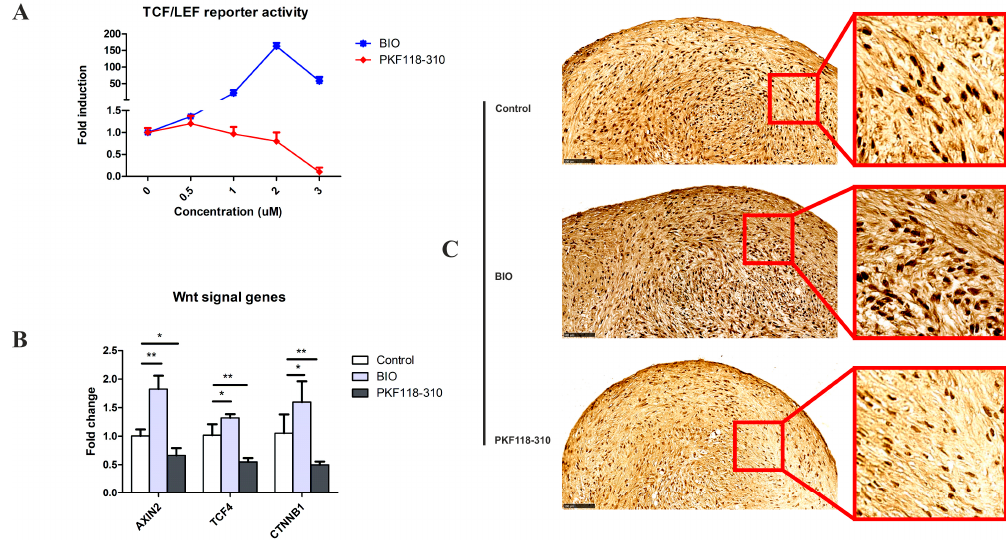
Figure 1. The efficacy and specificity of BIO and PKF on TCF/LEF reporter and hMSCs. ( A ) TCF/LEF reporter assay. To measure TCF/LEF reporter activity, HEK293T cells were infected with a lentiviral TCF/LEF reporter construct and stimulated with different concentrations of BIO or PKF for 24 hours (h), and luciferase activity was measured using the Dual-Glo luciferase assay kit. Data was expressed as fold change compared to control. ( B ) The expression of WNT signaling responsive genes in hMSCs. * p -value ( p ) < 0.05; ** p < 0.01. The error bar represents the Standard Deviation (SD). ( C ) Immunohistochemistry of β -catenin in hMSCs pellets. The expression of β -catenin was detected by rabbit anti-human β -catenin antibody, followed by incubation with the biotinylated secondary anti-rabbit antibody and horseradish peroxidase (HRP)-Streptavidin using a DAB (3 (cid:48) -Diaminobenzidine) substrate kit. Images were taken by using a Nanozoomer. Scale bar = 100 µ